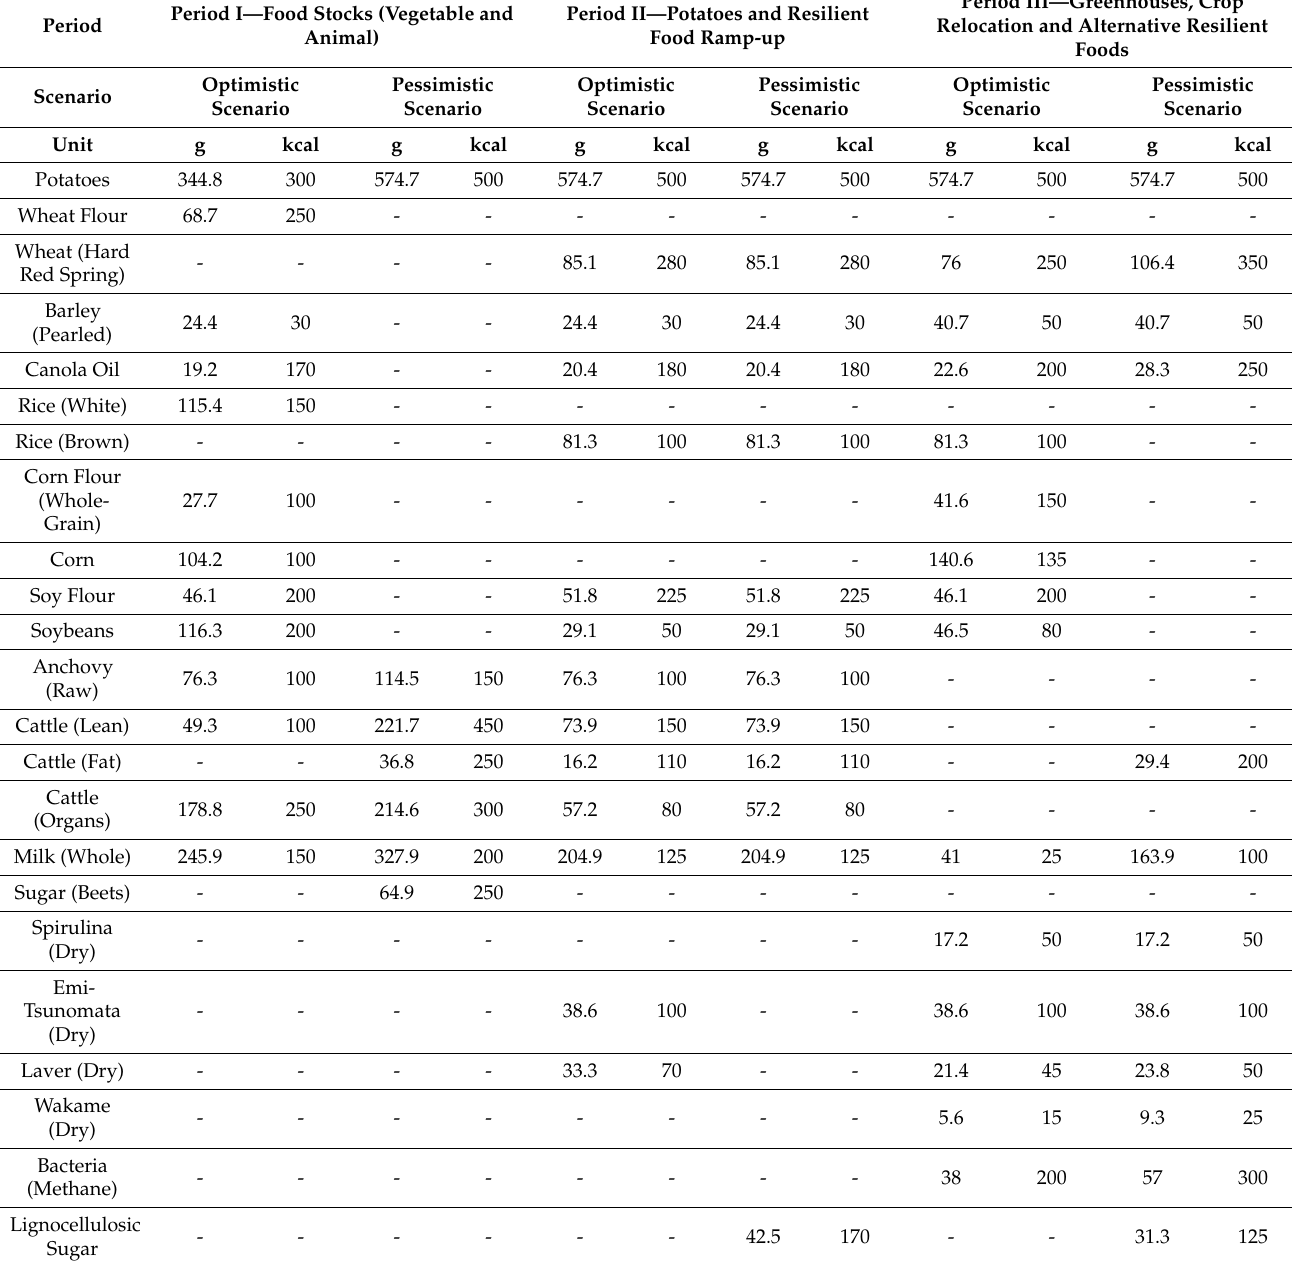
Table 3. Distribution of caloric and weight intake of resilient foods in optimistic and pessimistic scenarios in each